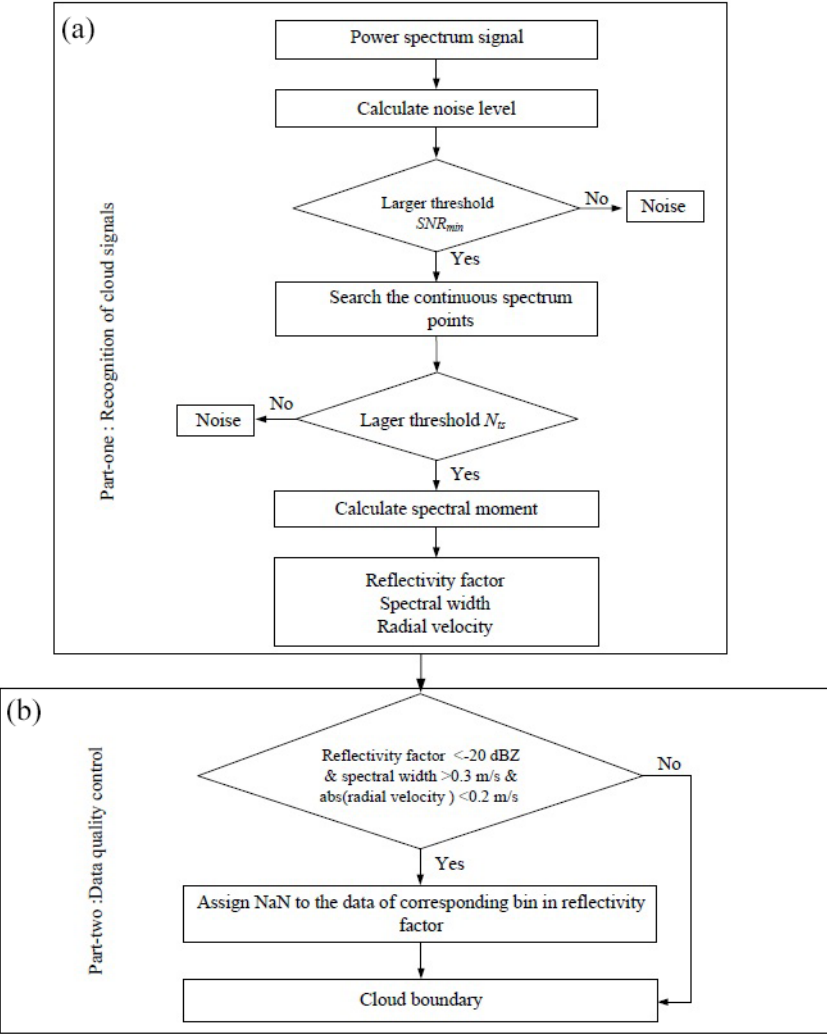
Figure 6. Flow chart of MMCR cloud boundary detection. (a) Recognition of cloud signals from Doppler spectra of MMCR and (b) cloud boundary with data quality